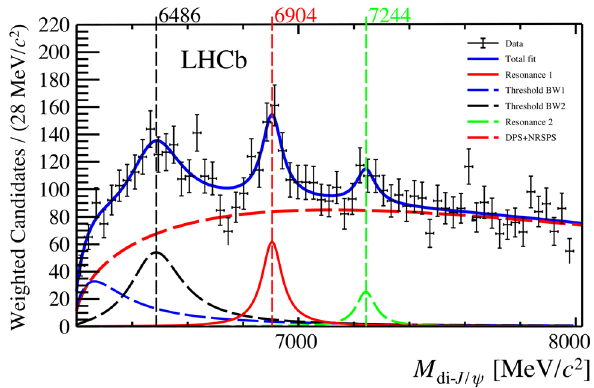
Fig. 1 Location of peaks in the LHCb data. Adapted from figure 7 in [1]. The 7.2 GeV state appears to be almost exactly on the (cid:2) cc ¯ (cid:2) cc threshold, which is at 7242 MeV